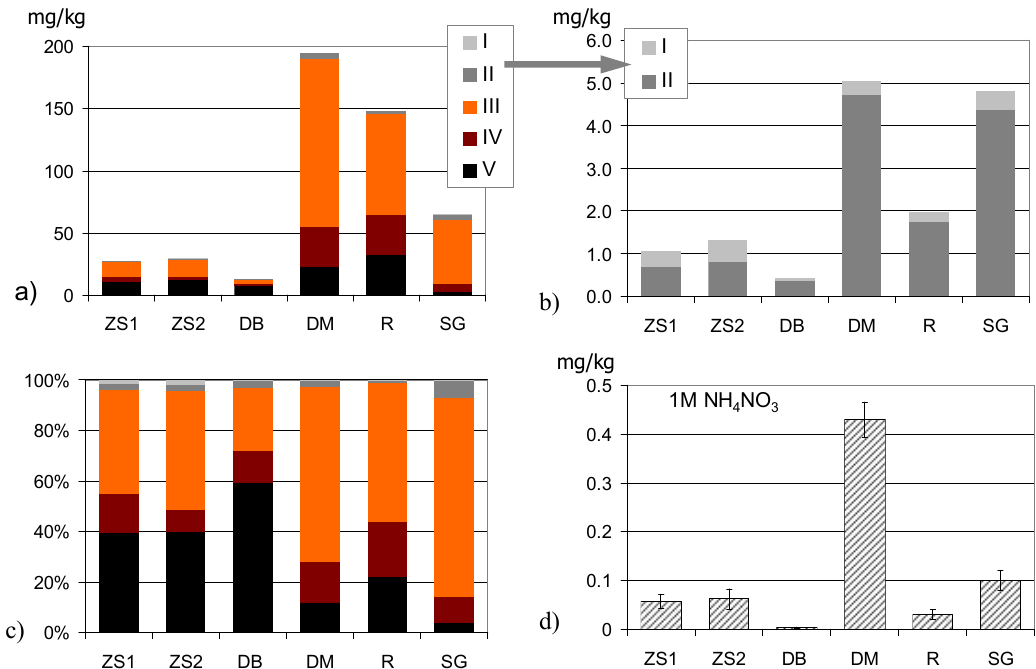
Figure 3. Figure 3. The amounts of Sb extracted from soils in the sequential extraction according to Wenzel et al. [52] (diagrams a – c ), as well as in the single extraction with 1 M NH 4 NO 3 (diagram d ). Error bars presented for extraction with 1 M NH 4 NO 3 stand for standard deviation of three replicates.